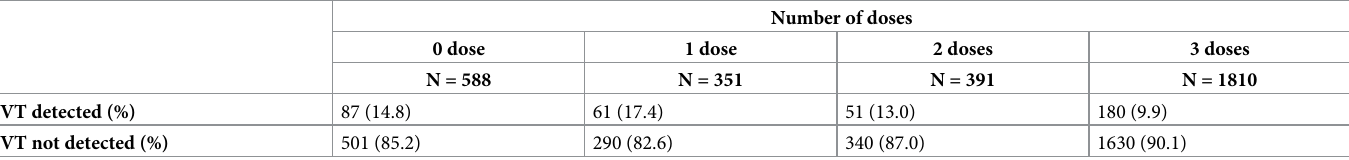
Table 3. The carriage rate of VT serotypes by number of doses of